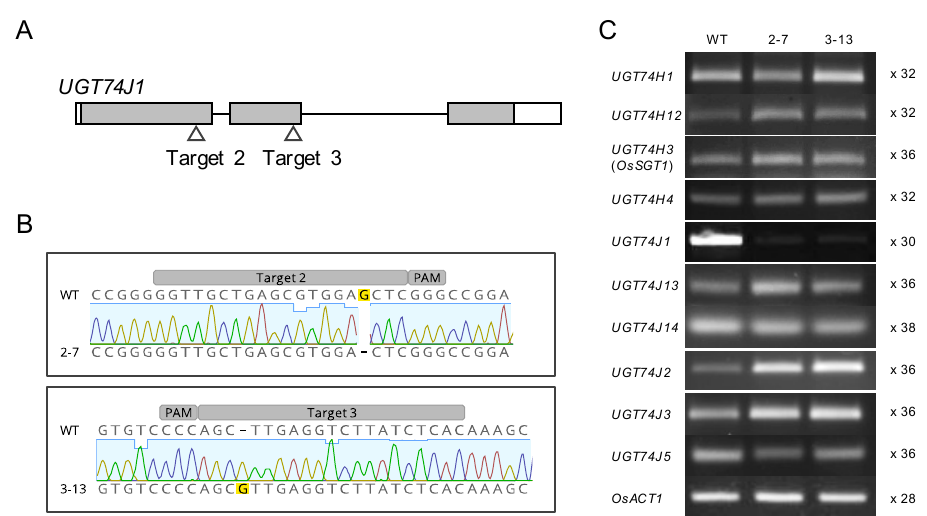
Figure 3. Creation of the ugt74j1 mutants by genome editing. ( A ) A schematic model of the CRISPR/Cas9 target sites on UGT74J1 . Gray and white boxes indicate the exon and untranslated region of UGT74J1 . ( B ) The genotypes of two independent mutants, 2–7 and 3–13. A partial fragment including the CRISPR/Cas9 target site was amplified from the mutants and aligned with the wild- type sequence. ( C ) The expression of UGT74 genes in the mutants. Total RNA was extracted from 14-d-old plants. Semi-quantitative RT-PCR was performed using gene-specific primers, and the cycle numbers applied are indicated at the right column. OsACT1 was used as an endogenous control.